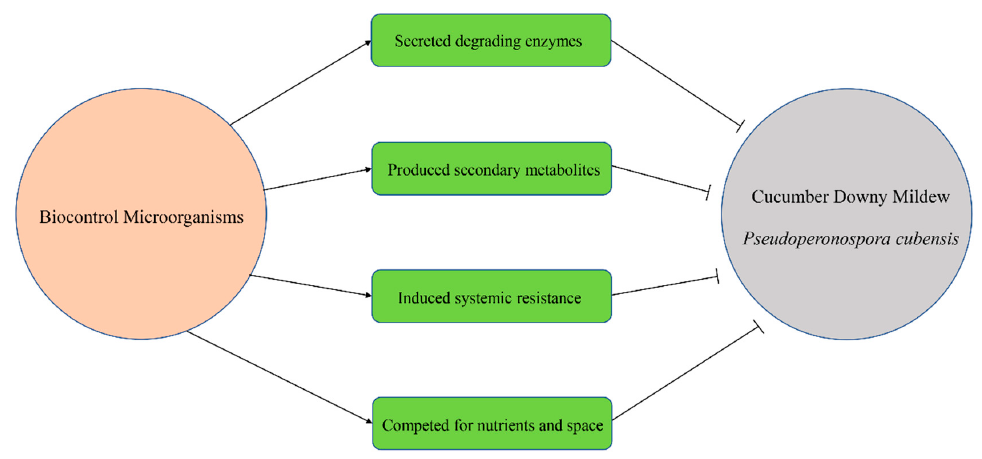
Figure 2. Mechanisms of biocontrol agents to suppress cucumber downy mildew caused by Pseudoperonospora cubensis .